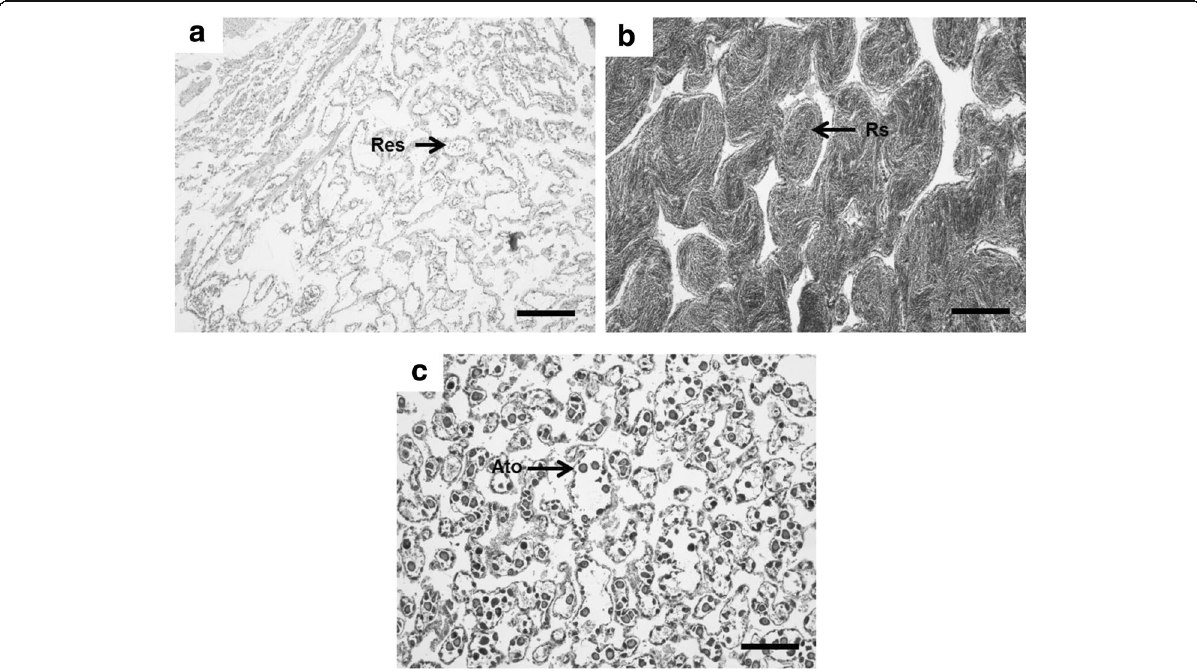
Fig. 2 Photomicrographs of transversal section of representative Akoya pearl oyster ( P. fucata ) gonads showing stages in gametogenesis ( a ) male gonad in resting stage with residual spermatozoa, ( b ) male gonad in mature stage with ripe spermatozoa in dense volume, ( c ) female gonad in resting stage with residual or atretic oocytes. Res, residual spermatozoa; Rs, ripe spermatozoa; Ato, atretic oocyte. Scale bar, 200 μ